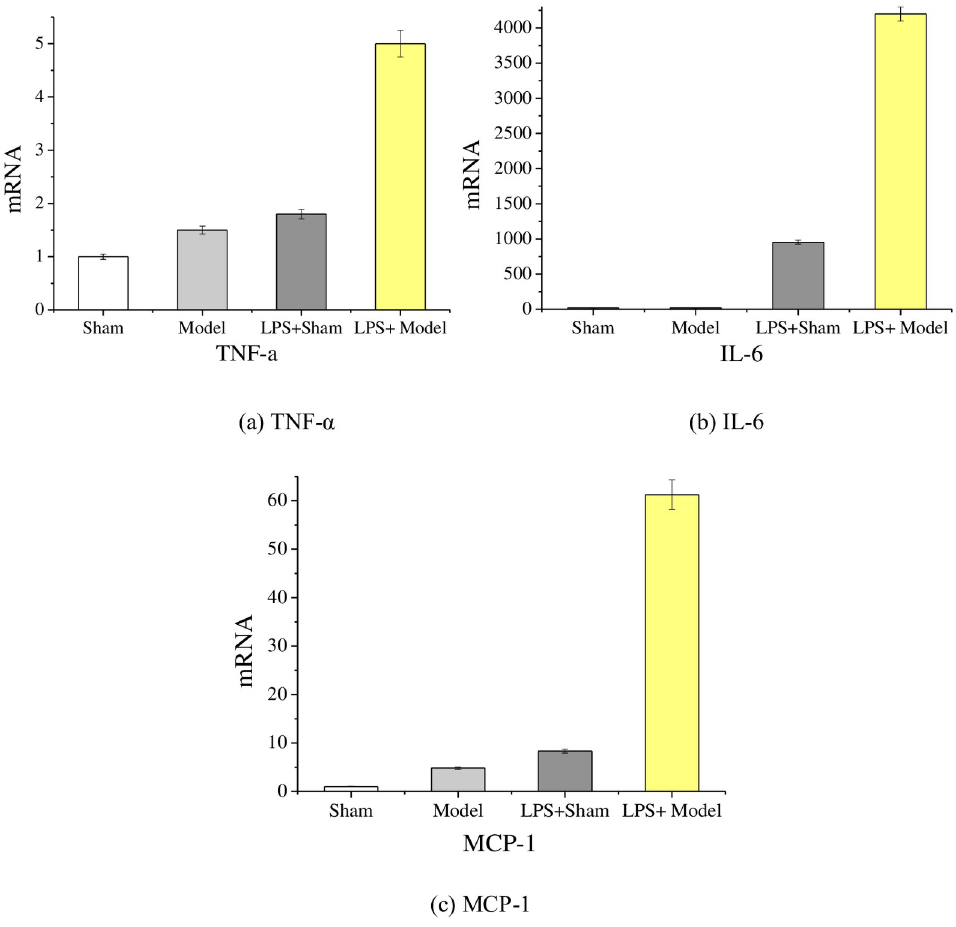
Fig 3. Comparison of M1 marker expression in peritoneal macrophages of two groups of rats.